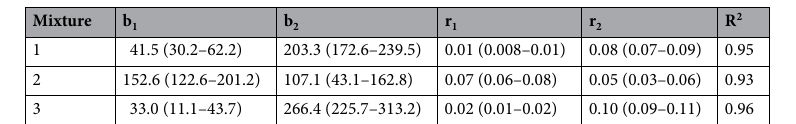
Table 2. Parameter estimates of the model fit to disease severity data in two-component barley mixtures. Numbers in parantheses are delete-one jackknife confidence intervals.